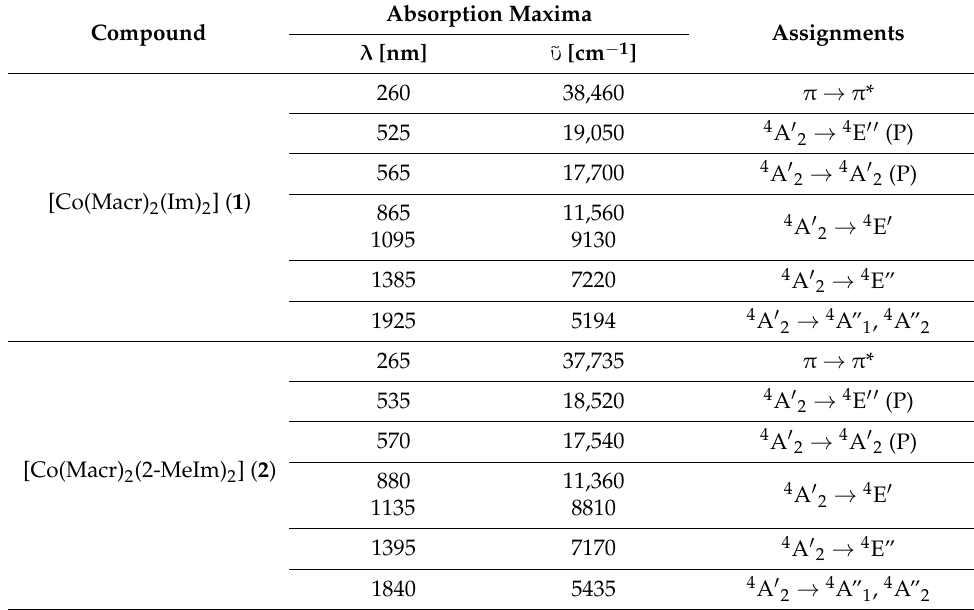
Table 4. Absorption maxima in UV-Vis-NIR spectra of complexes ( 1 )–( 3 ).